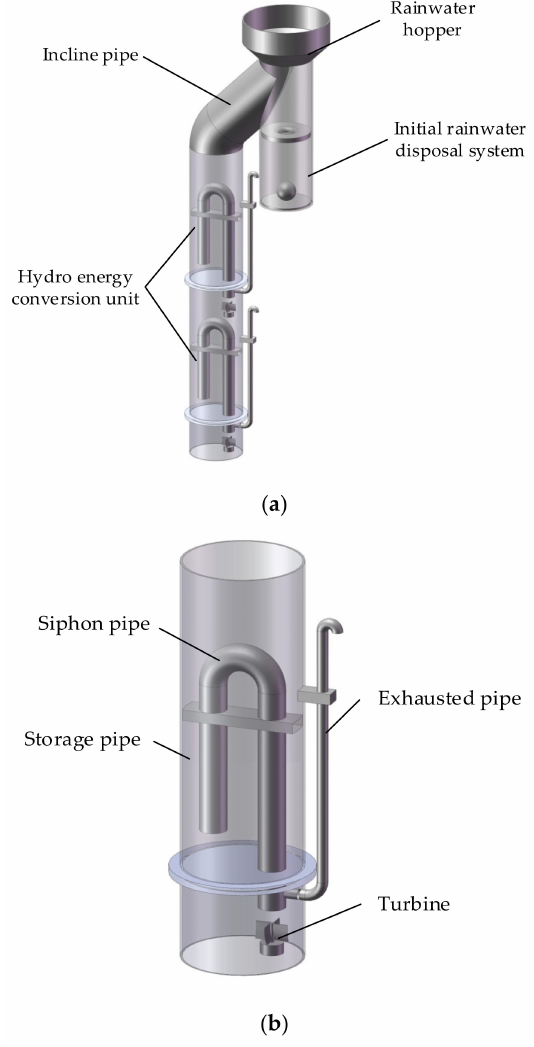
Figure 2. Geometric model of the overall system: ( a ) Rain-Power Utilization System; ( b ) hydro energy conversion